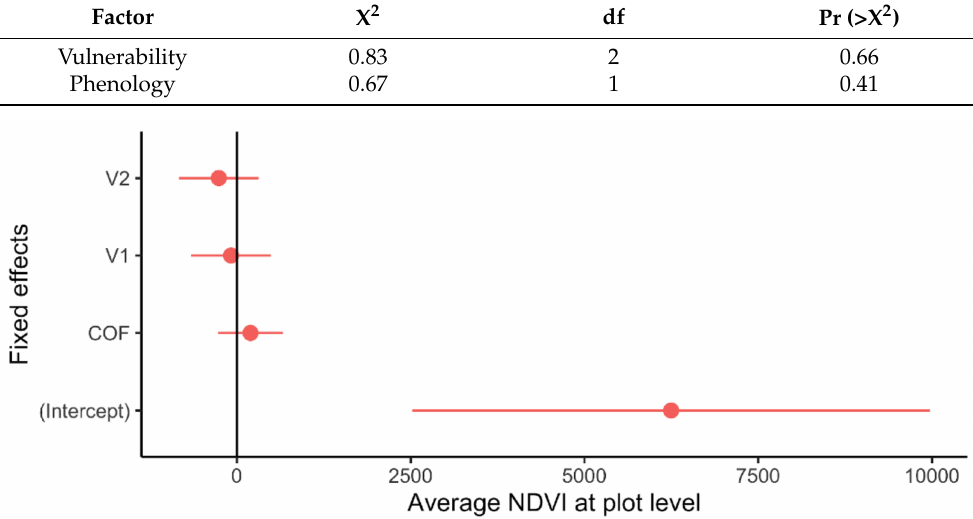
Table 2. Model 1, deviance table of the fixed effects for the average NDVI at plot level during year 1 (df: degrees of freedom). No experimental design factors affected the NDVI before experimentation took place.